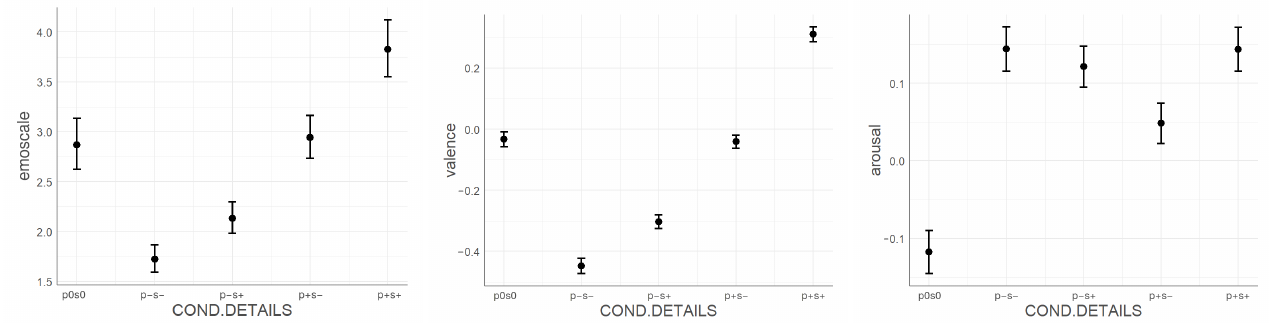
Figure 9. Mixed model of the influence of specific stimuli conditions on: the emoscale widget response ( left ), the emospace valence vector response ( center ), and the emospace arousal vector response ( right